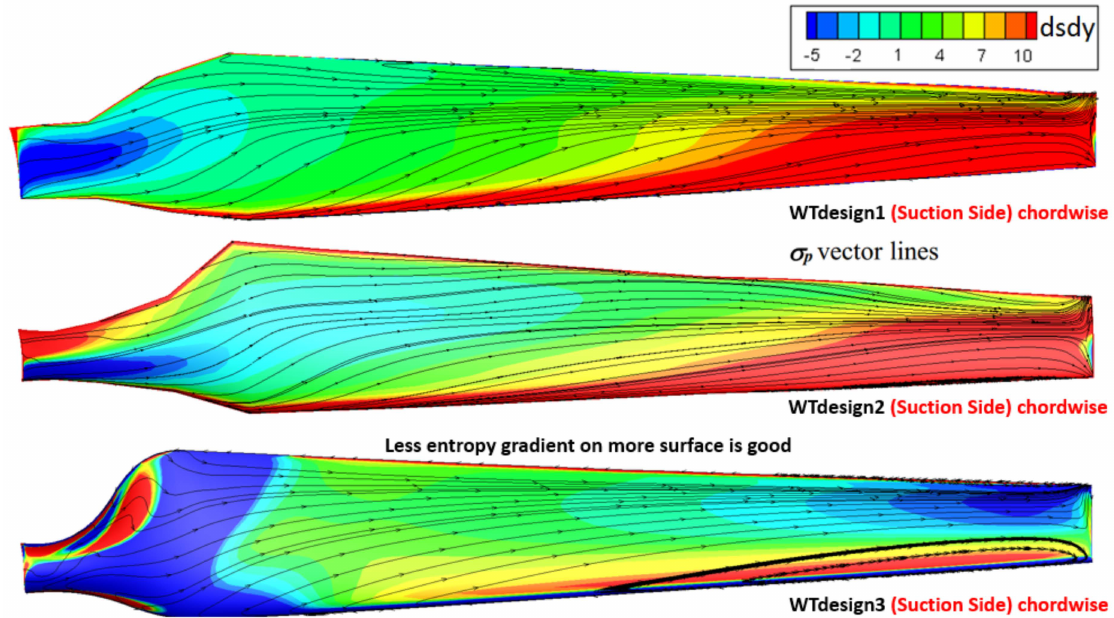
Figure 33. Chordwise entropy gradient with BVF due to tangential pressure gradient vector and σ p lines on design 1, 2 and 3 compared.